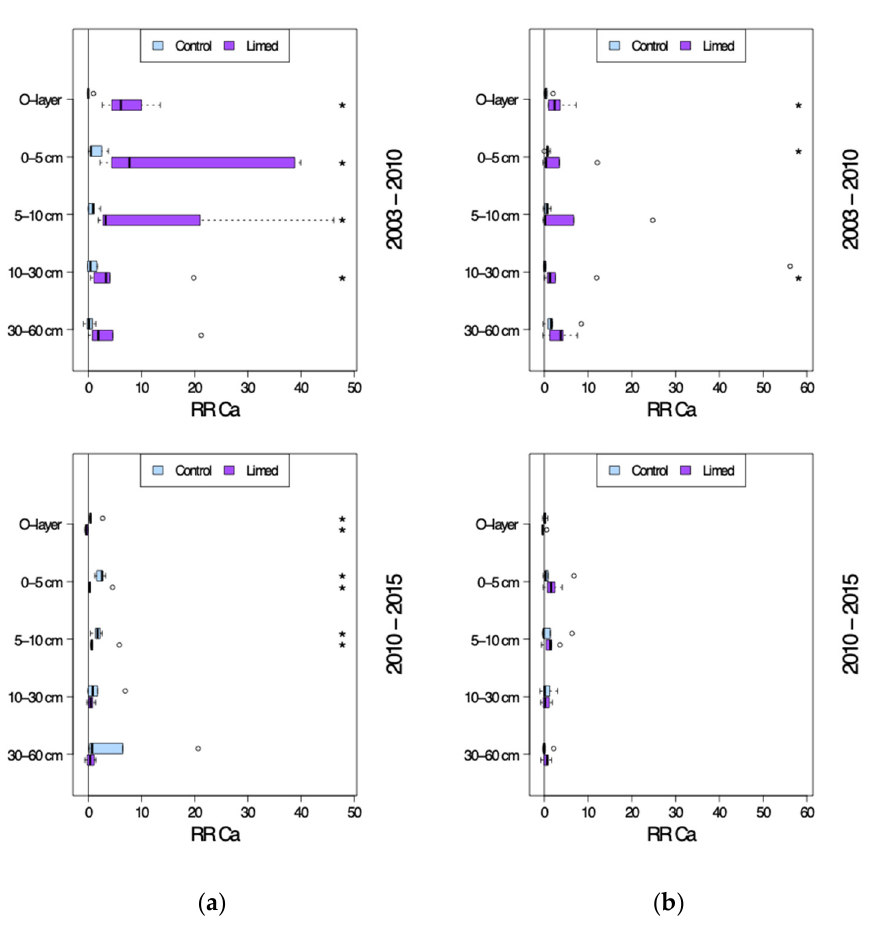
Figure 7. Calcium response ratio (RR r ) in the soil profile seven years after (2003–2010) and twelve years after the second lime treatment (2010–2015): ( a ) G1 sites and ( b ) G2 sites. *—significant differences between current and previous sampling campaign.